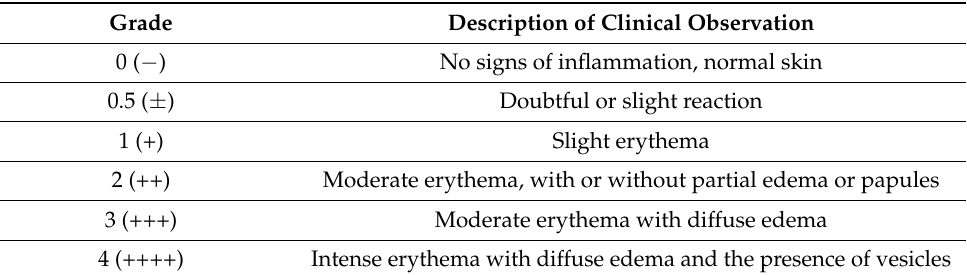
Table 1. Skin irritation score system.